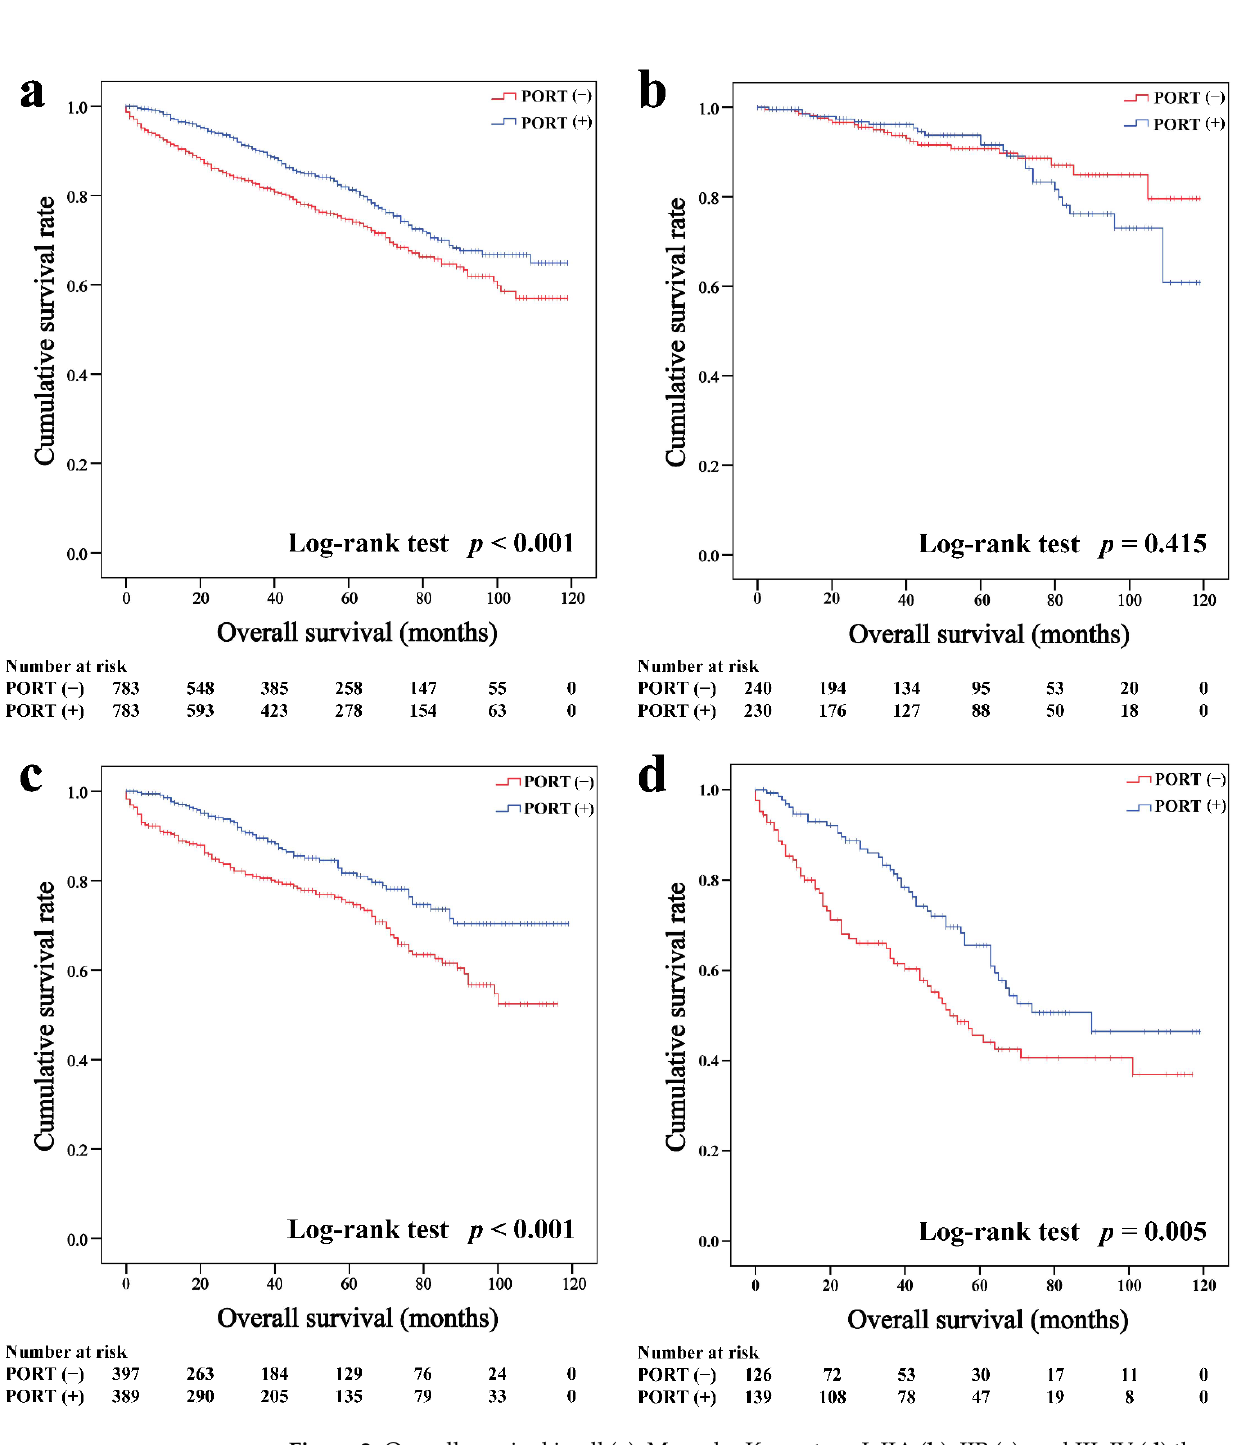
Figure 2. Overall survival in all ( a ), Masaoka-Koga stage I–IIA ( b ), IIB ( c ), and III–IV ( d ) thymoma patients.